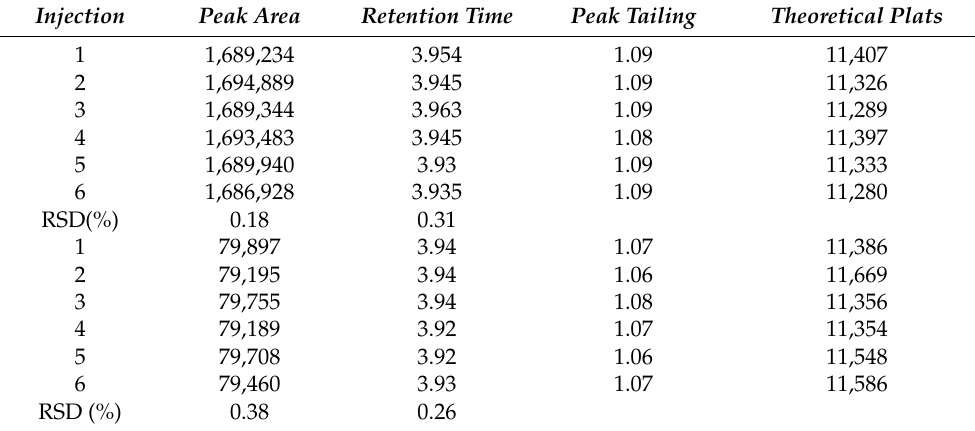
Table 2. System suitability results (peak area, retention time, peak tailing and theoretical plates) at two different concentrations of RSV (top: 0.40 mg/mL; bottom: 0.02 mg/mL). Chromatographic conditions: column, Acquity BEH C18 (100 mm × 2.1 mm, 1.7 µ m); mobile phase, MeOH-TFA